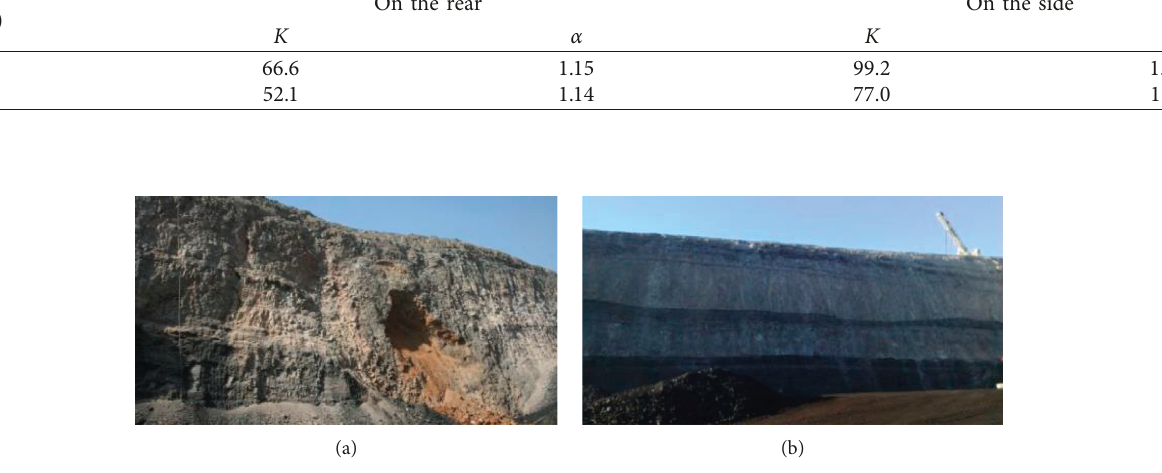
Figure 12: Presplit blasting effect. (a) Presplit face when S � 4.0m and (b) presplit face when S �